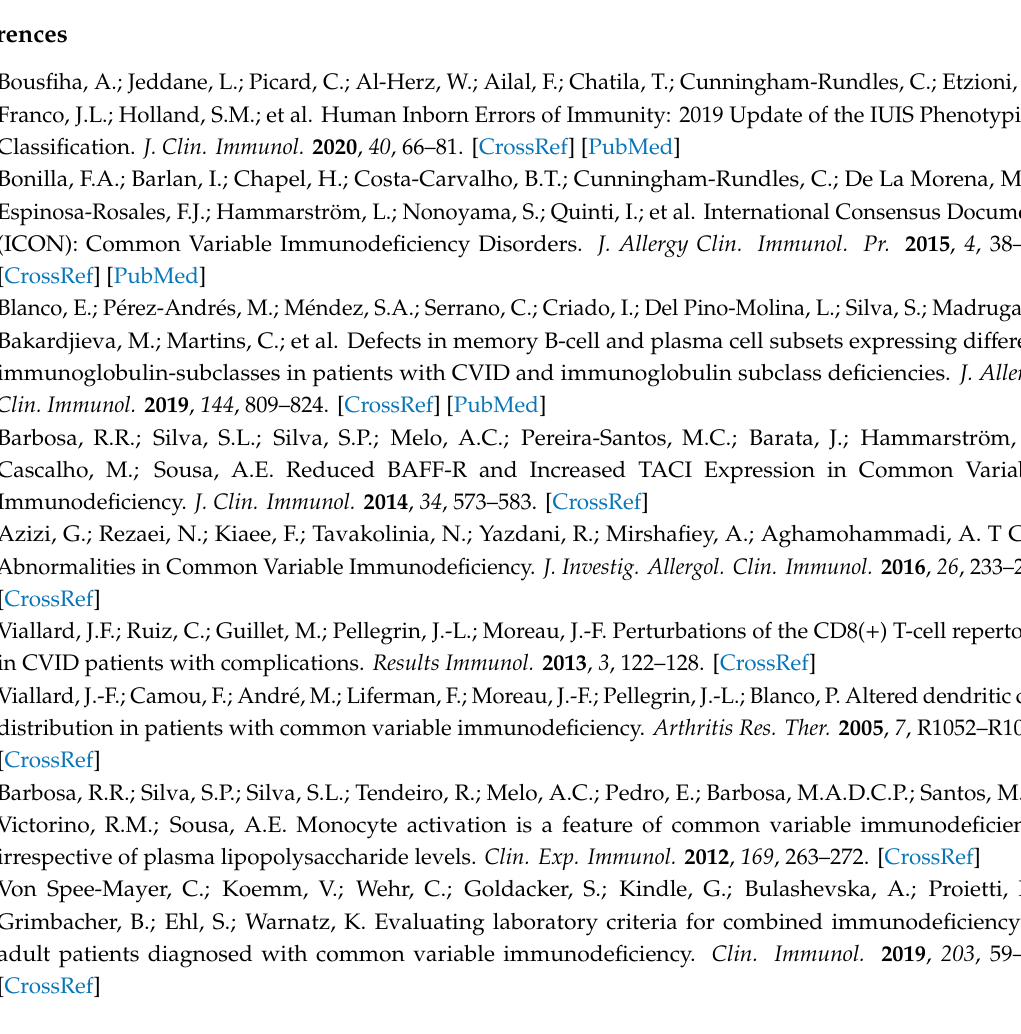
Table S1: Detailed IHC protocol for the antibodies used in this study, Table S2: Detailed clinico-pathological characteristics of CVID patient cohort, Table S3: Detailed results of the immune cell counting (Foxp3, GATA3, CD4, CD8, CD20) in non-neoplastic mucosa (distant from and adjacent to tumour) and adenocarcinomas of CVID patients in comparison with non-CVID patients infected by Helicobacter pylori . Figure S1: Immune cell counting in epithelial and lamina propria compartments in adenomatous lesions from CVID and non-CVID patients. No statistically significant di ff erences were found when CVID and non-CVID patients were